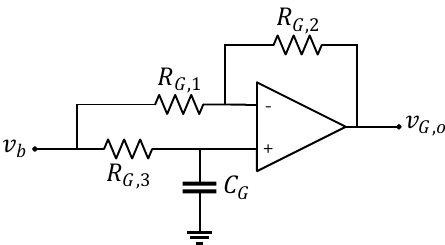
Figure 6. Implementation of G ( s ) . The values of the discrete components are R G ,1 = 1 Ω , R G ,2 = 50 Ω , R G ,3 = 1 M Ω , and C G = 1